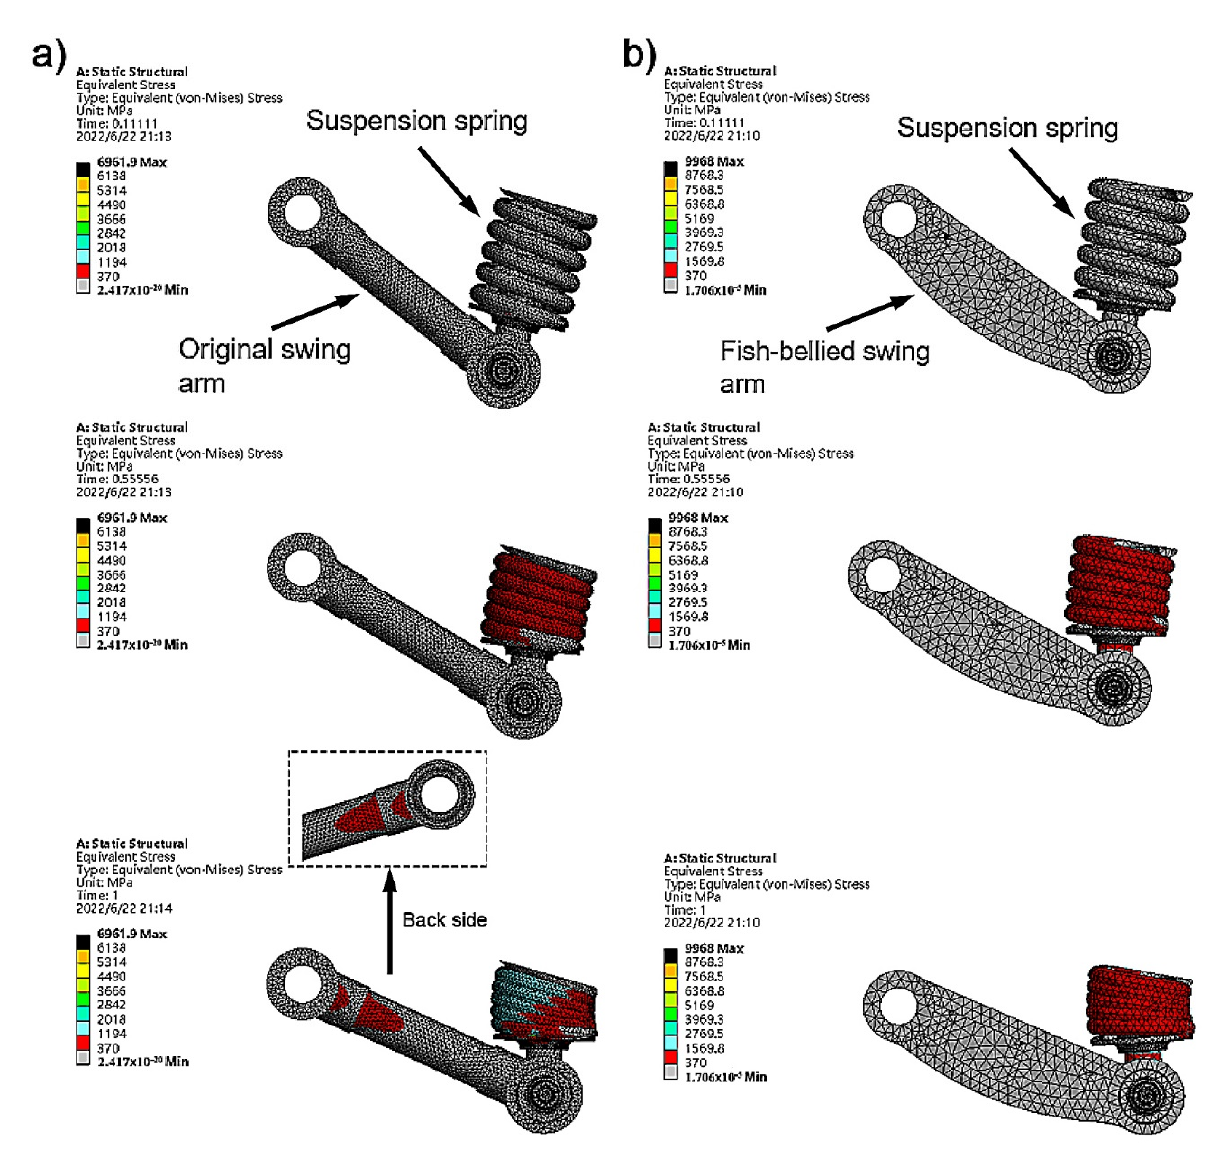
Figure 5. Force simulation of swing arm before and after improvement. ( a ) The deformation process of the original swing arm; ( b ) The deformation process of the fish-bellied swing arm.